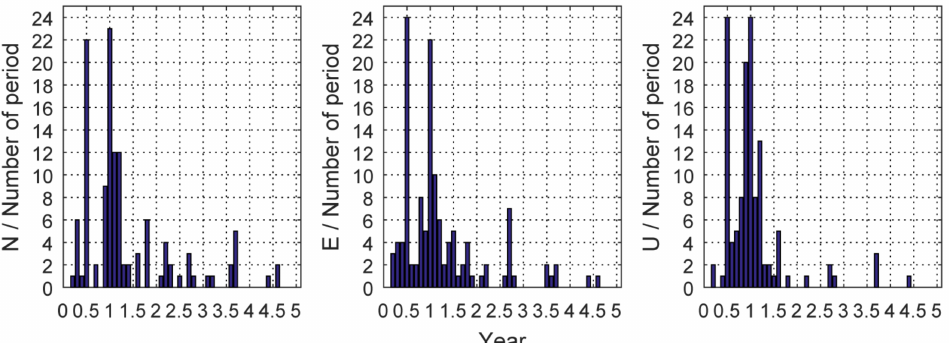
Figure 3. Statistical results of periodic items information for 24